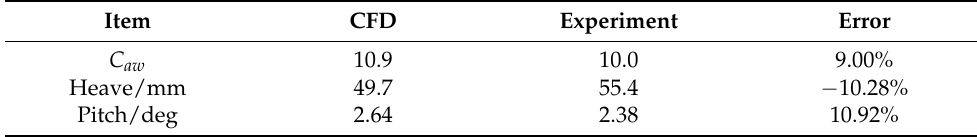
Table 8. Comparison of added resistance and motion of KCS in waves with experimental data.